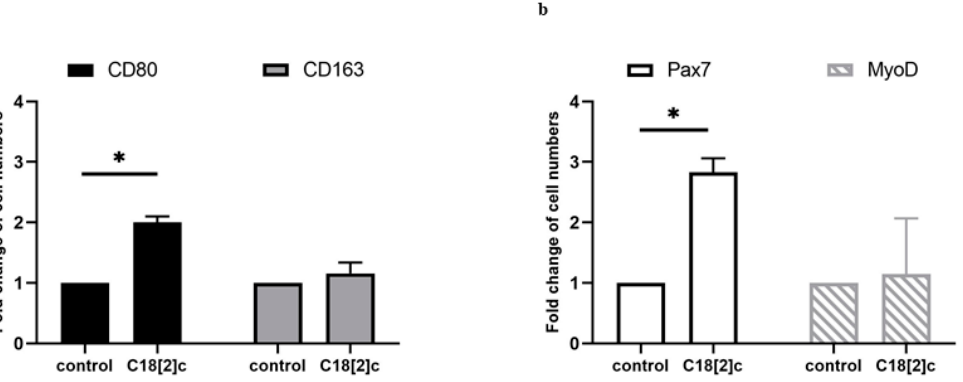
Figure 4. M1 macrophages and satellite cells were increased in human skeletal muscle tissue in response to unsaturated fatty acid C18[2]c. Skeletal muscle tissue sections from donor 6 were stimulated with C18[2]c or left untreated for 9 days (control) and analyzed for the presence of M1 (CD80-positive) or M2 (CD163-positive) macrophages, satellite cells (PAX7-positive), or myoblasts (MYOD-positive) using immunofluorescence and DAPI staining. ( a ) The diagram shows the mean fold change of M1 (CD80-positive) (black bars) and M2 (CD163-positive) macrophages (gray bars) in 0.24 mm 2 of muscle fibers, which was determined by normalizing the number of cells in the stimulated sample to that of the unstimulated sample. ( b ) The diagram shows the mean fold change of PAX7-positive satellite cells (white bars) and MYOD-positive myoblasts (hatched bars) in 0.24 mm 2 of muscle fibers, which was determined by normalizing the number of cells in the stimulated sample to that of the unstimulated sample. Thus, the controls were set to one. p ≤ 0.01 (*).